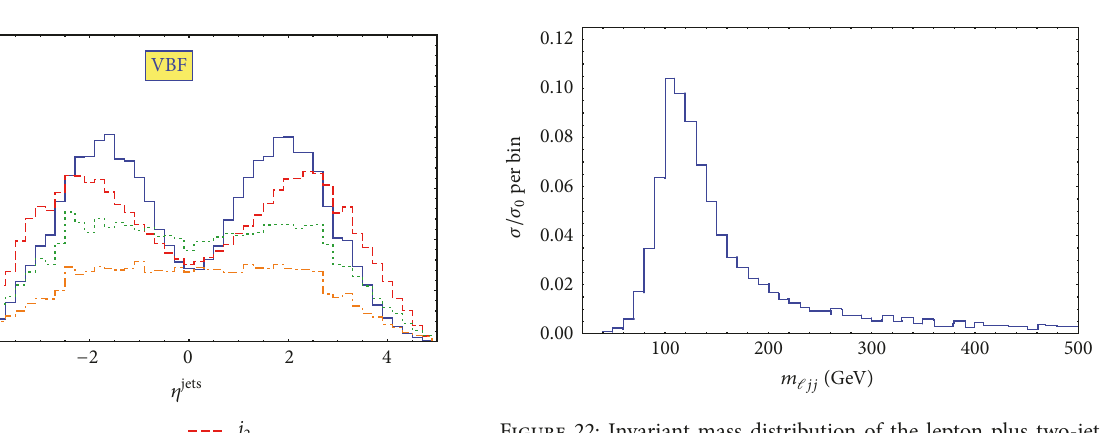
Figure 22: Invariant mass distribution of the lepton plus two-jet systems (𝑚 ℓ𝑗𝑗 ) from the ℓ + MET + 2𝑗 + 𝑋 final state from the pp → 𝑁 ] 𝑋 process. The lepton plus two-jet system shows a peak around 𝑚 𝑁 ∼ 100 GeV.